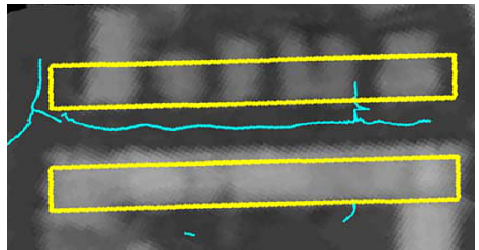
Figure 2: nDSM with 3D-line extraction result (cyan) and region mask for computing entropy